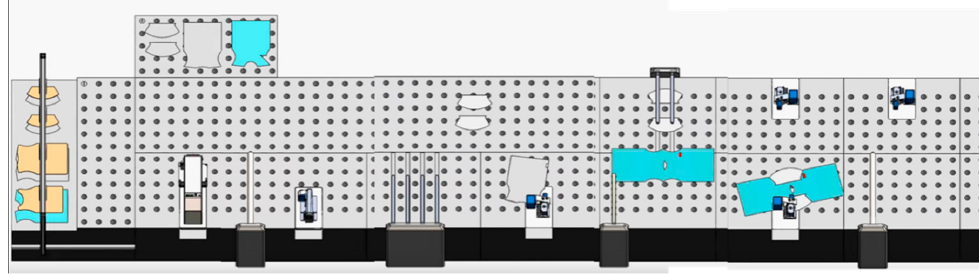
Figure 8. Automatic sewing production live.